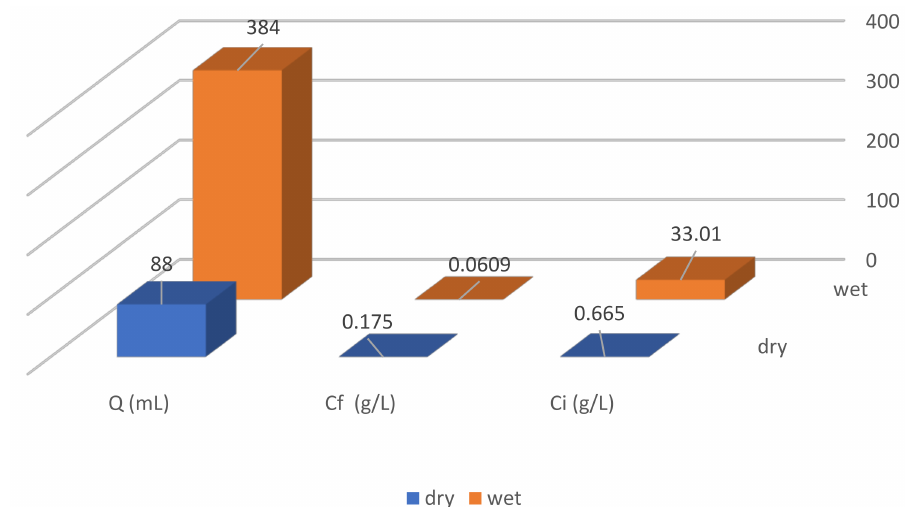
Figure 5. Effect of dry and wet packing after 2 h operation.